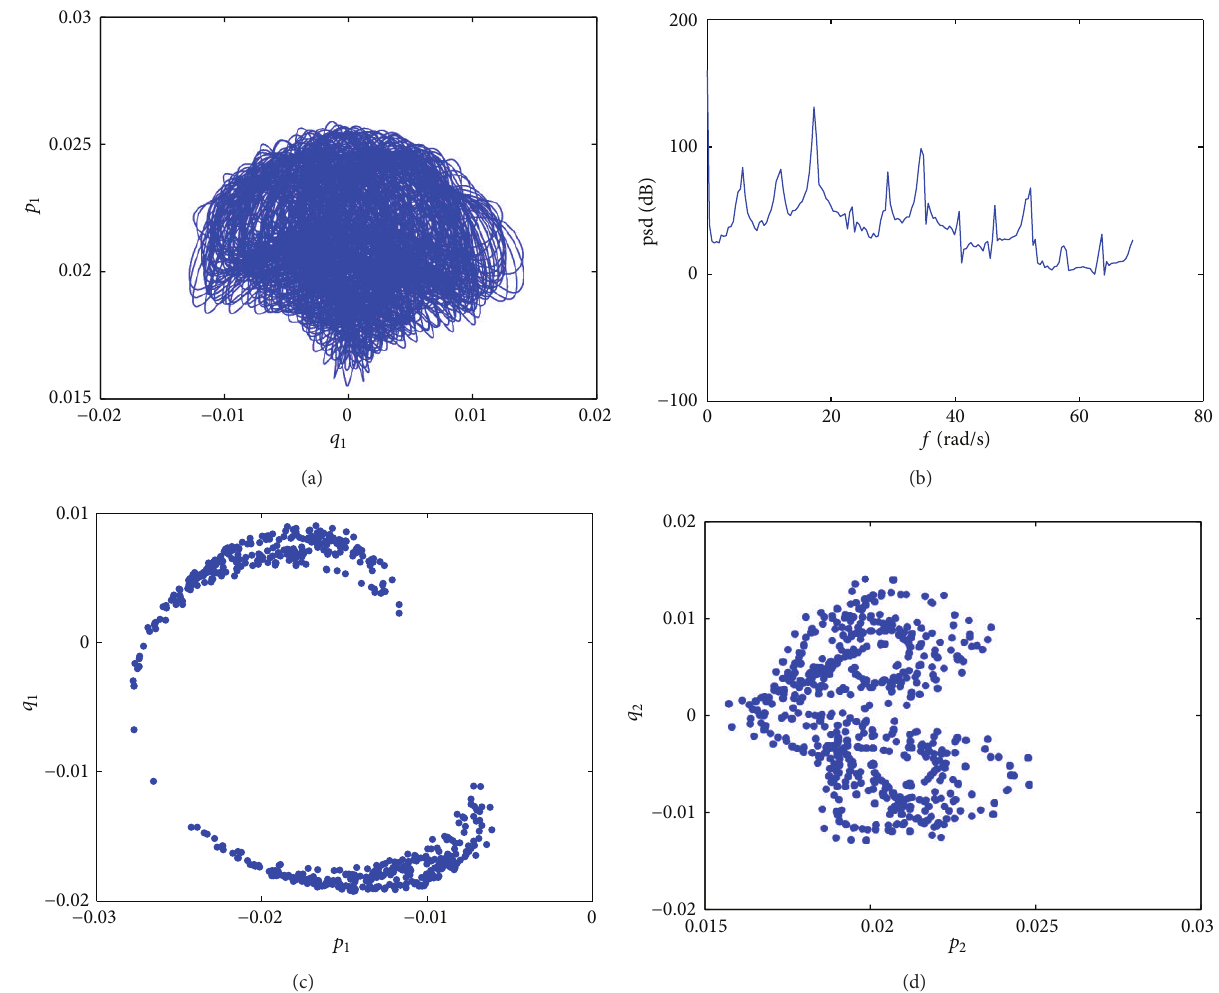
Figure 15: Phase portrait (a), FFT power spectra (b), and Poincare maps (c, d) for 𝜎 2 = 117.4201 , 𝜇 = 0.05 , V 1 = 10 , 𝛼 = 0 , and 𝜎 1 = 92.39